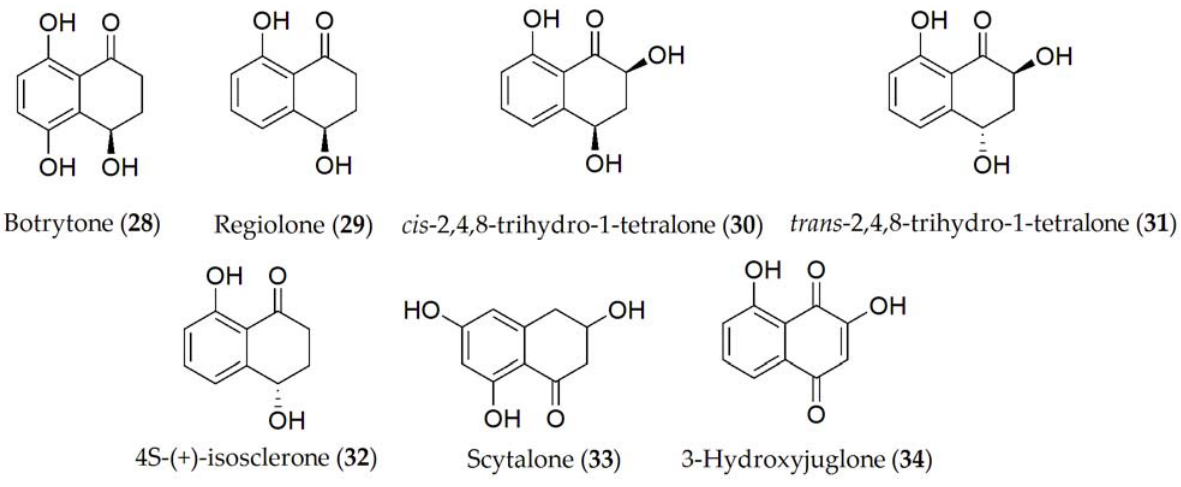
Figure 6. Phytotoxins isolated from Botrytis fabae .